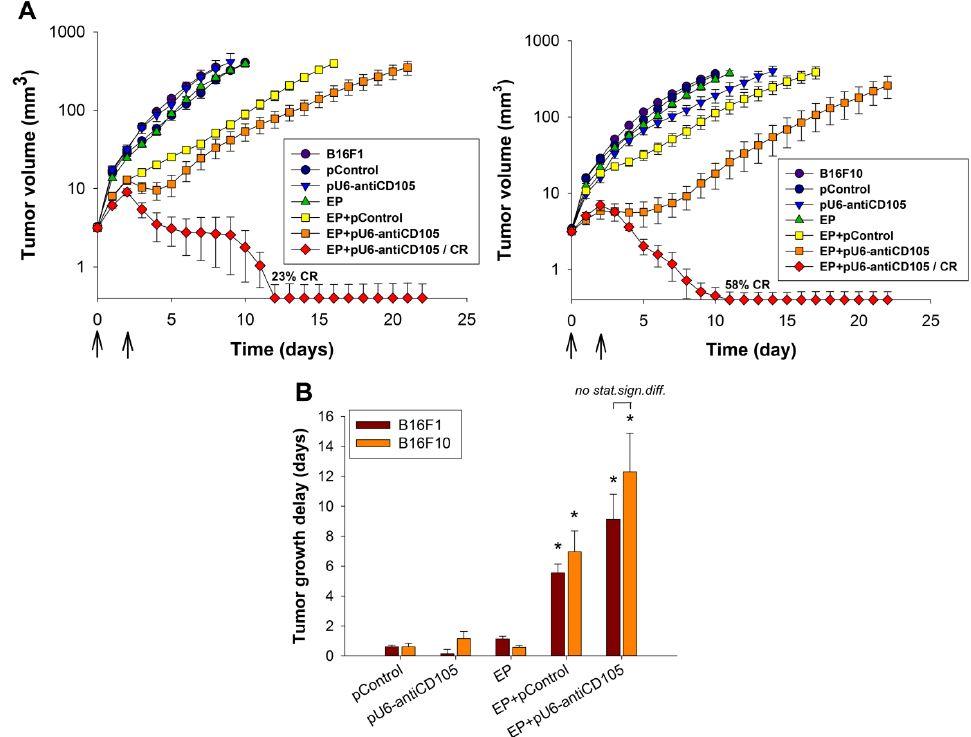
Figure 4. The growth of melanoma tumors in mice after endoglin silencing. ( A ) The growth of B16F1 and B16F10 tumors and their ( B ) tumor growth delay after gene electrotransfer of pU6-antiCD105. CRs were not included in the calculation. Arrows indicate the day of the treatments. All data are expressed as arithmetic mean ± standard error of the mean. Asterisks indicate statistically significant differences between EP+pU6-antiCD105 and the control groups (* p < 0.05). CR = complete response. The data are from one experiment with n = 12.